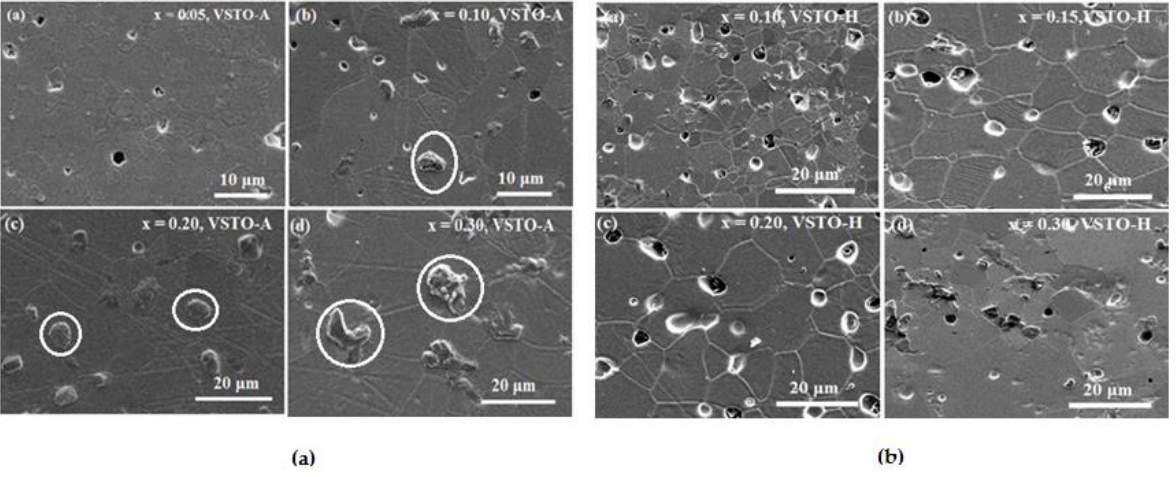
Figure 3. SEM micrographs for ( a ) VSTO-A and ( b ) VSTO-H ceramics .